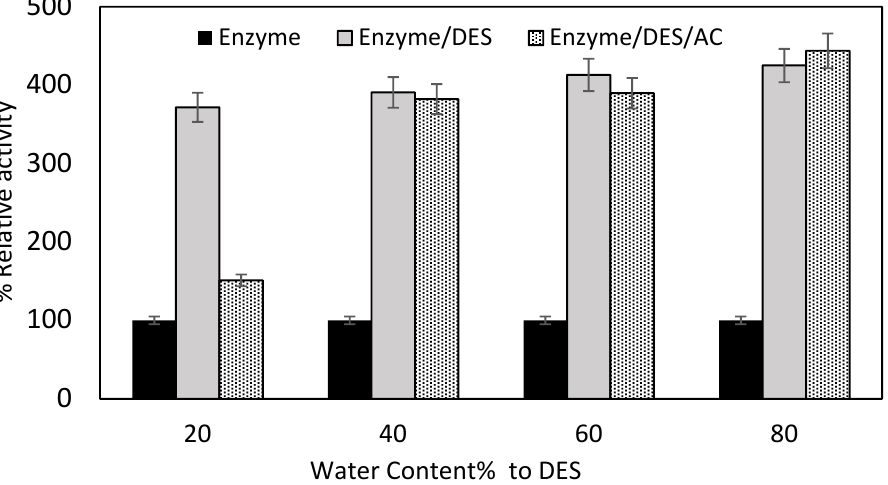
Figure 7. Activity of immobilized and free porcine pancreas lipase (PPL) at different concentrations of aqueous DES (1:1 NaOH: Alanine).